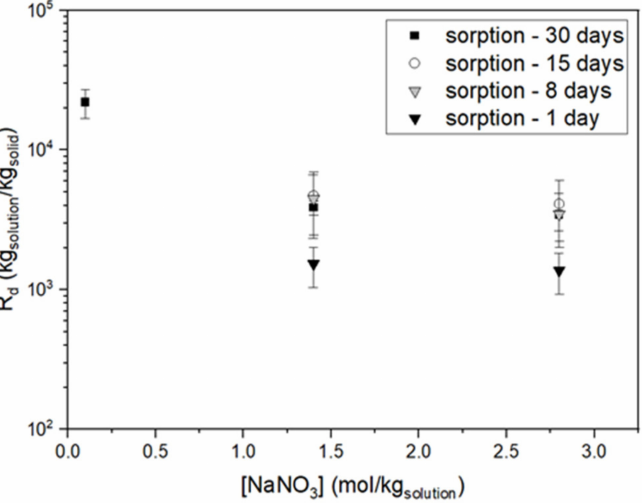
Figure 5. U(VI) sorption kinetics as a function of NaNO 3